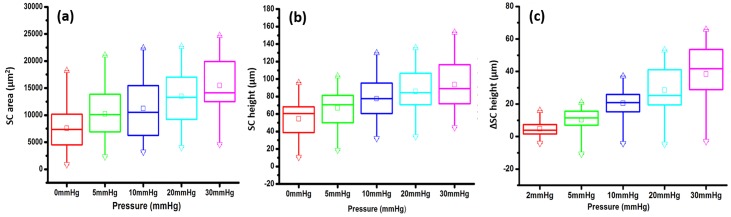
(A), (B), and (C) are boxplots of the data for Schlemm’s canal (SC) area, height and height change respectively.Data is from 14 quadrants of 4 eyes in A & B and from 13 quadrants in C. SC height changes in C are reflected in the data of Fig 7, which displays normalized differences of individual quadrants. The boxplot central lines represent the median, and the box borders the interquartile distance. Means are represented by the small squares. Maximum value are shown as Δ, while minimum as inverted Δ. *p<0.05. The whiskers represent the 99% and 1% range of Tukey.